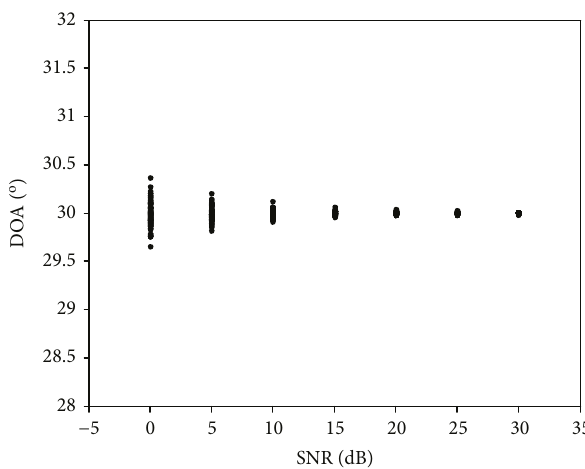
Figure 5: The scatter plot of DOA estimation under di ff erent SNRs.